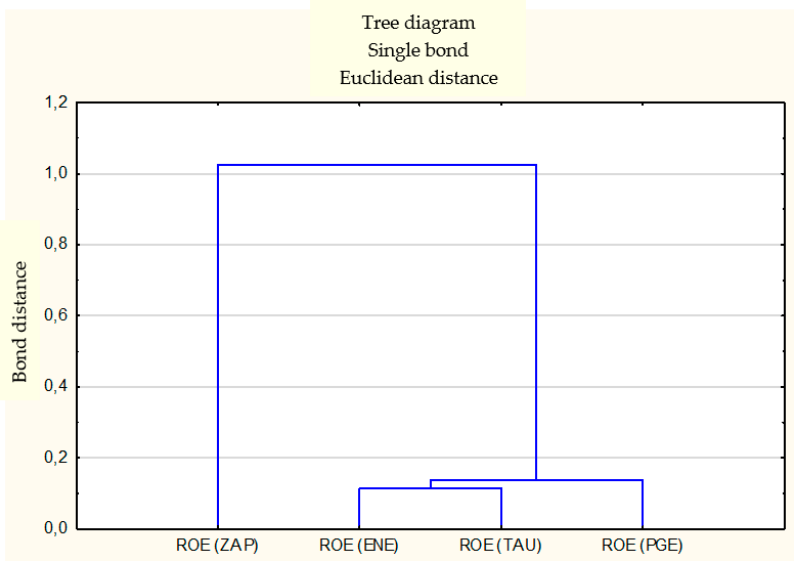
Figure 5. ROE ratios for the analyzed companies in 2009–2019 (%). Source: Own elaboration.